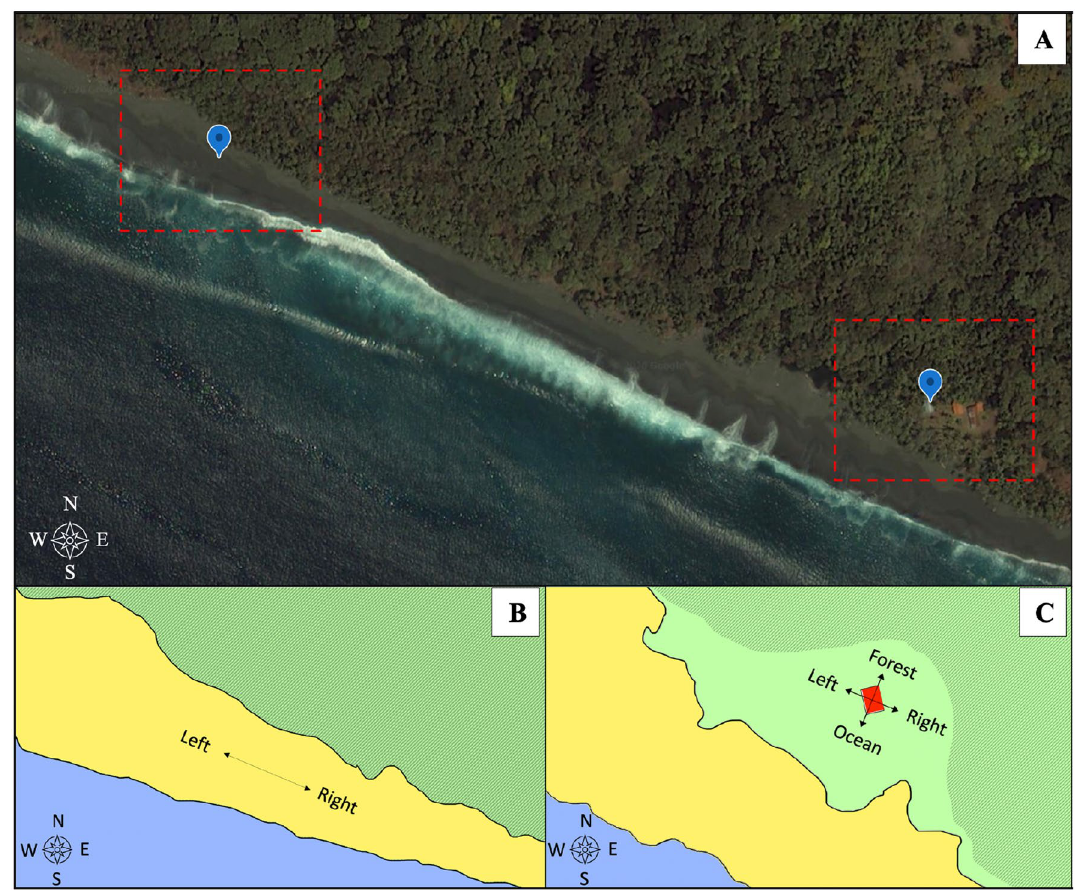
Figure 1. Study site and experimental areas. ( A ) Satellite view of study site: a section of Piro beach, Osa Peninsula, Costa Rica. Dashed red squares indicate areas where experiments were carried out and schematic versions are shown below in ( B ) and ( C ) (Satellite image: created using Google Earth Version 9, https:// earth. google. com/). ( B ) Overhead view of the section of the beach where free-roam experiments were carried out. Arrows denoting left and right correspond to stimulus directions during free-roam experiments. ( C ) Overhead view of the beach-forest interface where the handled experiments were carried out. Arrows denoting left, right, forest, and ocean correspond to stimulus directions during handled experiments. The solid red box represents the platform on which the artificial beach was created. For ( B ) and ( C ), environment is color coded: blue = ocean, yellow = beach sand, dark green = rainforest, light green = open grassy area with sparse trees. Compass in the bottom left of each panel shows cardinal